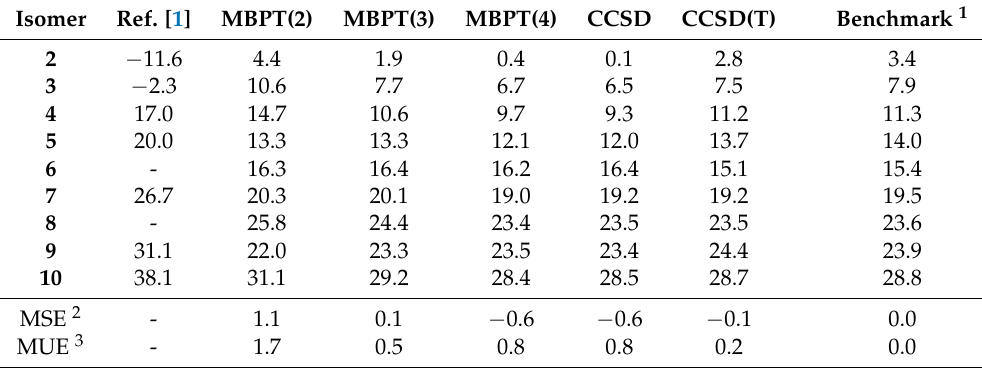
Table 2. Statistical evaluation of wave-function methods for determination of the relative energies of low-lying isomers of C 2 Si 2 H 4 . Isomer energies were computed as ∆ E = E ( 2 ) − E ( 1 ) . All values are in kcal/mol.